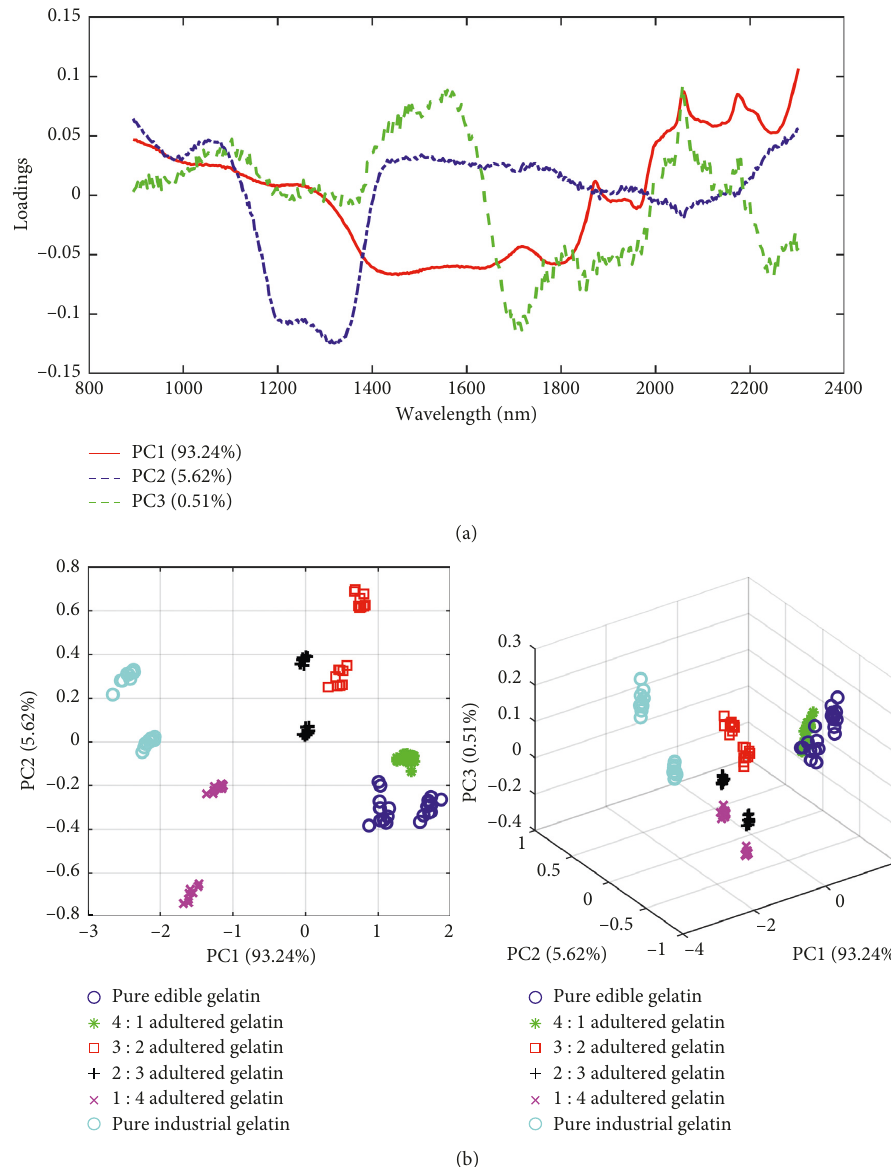
Figure 2: PCA loading plot: 2D and 3D score scatter plot of PC1, PC2, and PC3 for NIR spectra of gelatin samples. Table 2: Predicting results of the LDA model in the training set and validation set.